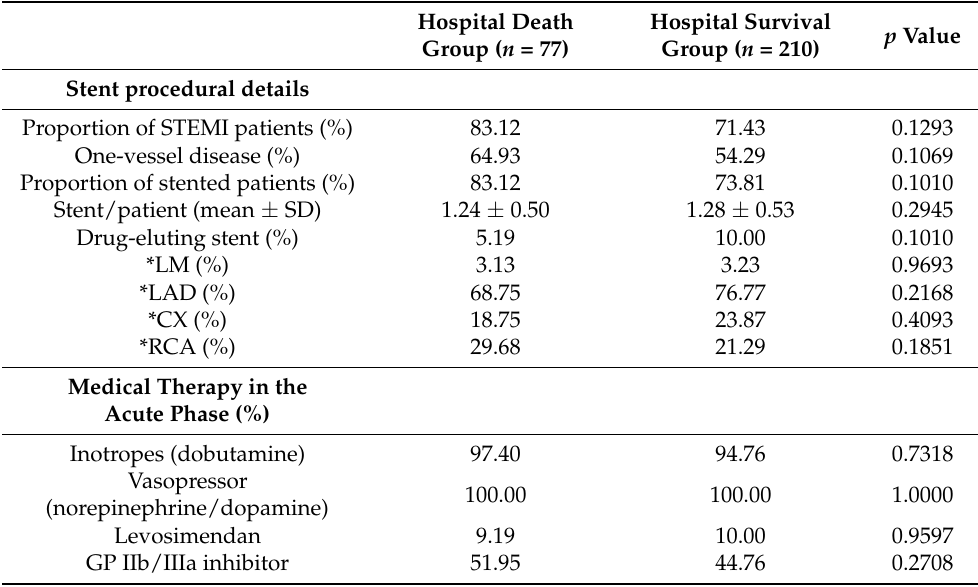
Table 2. Stent procedural details and medical therapy in the acute phase (first